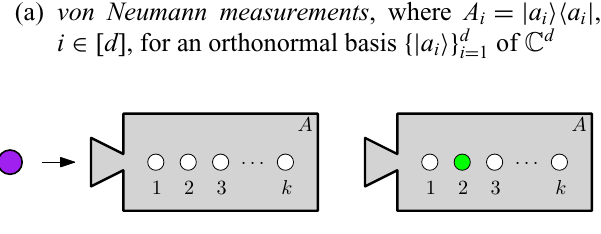
FIG. 2. A diagrammatic representation of a quantum measure- ment apparatus. The device has an input canal and a set of k light-emitting diodes that will turn on when the correspond- ing outcome is achieved. After the measurement is performed, the particle is destroyed and the apparatus displays the classical outcome (here,